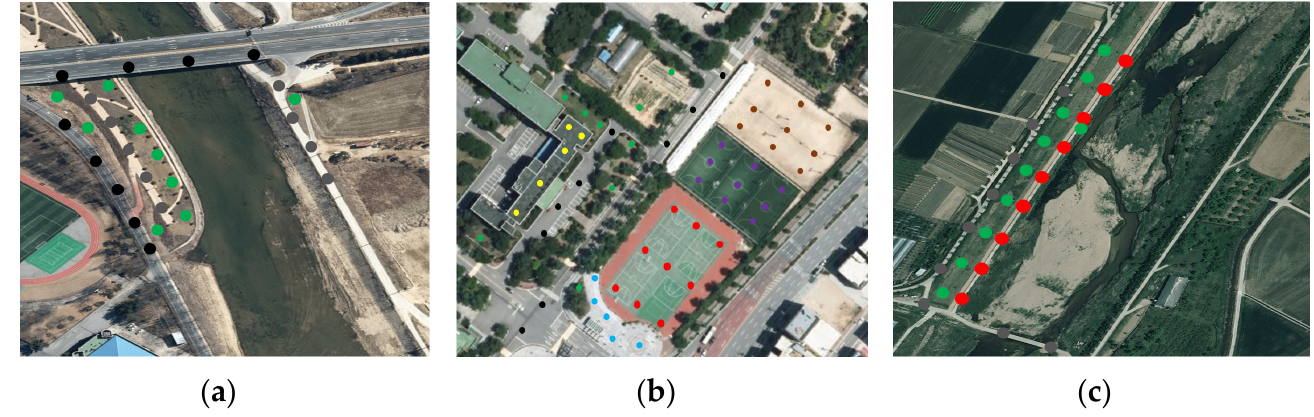
Figure 3. On-site measurement points by land cover: ( a ) plants, trees and river; ( b ) Kyungpook National University Sangju Campus; ( c ) farmland and river. The pointer color indicates land cover: red (urethane); purple (artificial turf); brown (soil); green (vegetation); sky blue (marble); black (asphalt); yellow (green roof); grey (concrete).